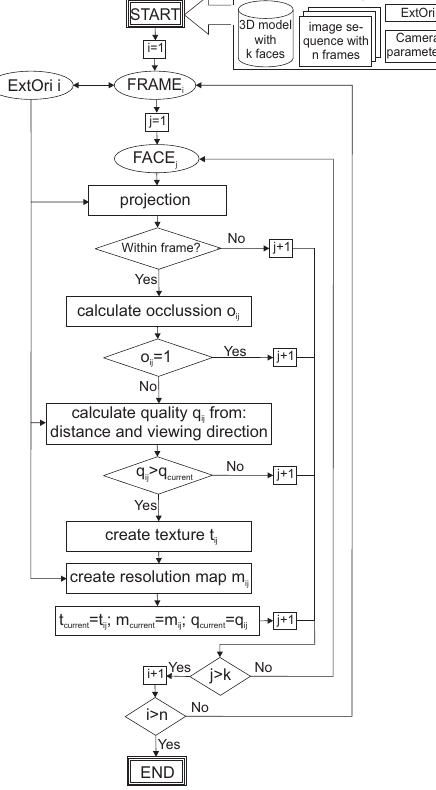
Figure 1. Texture mapping procedure with best texture selection